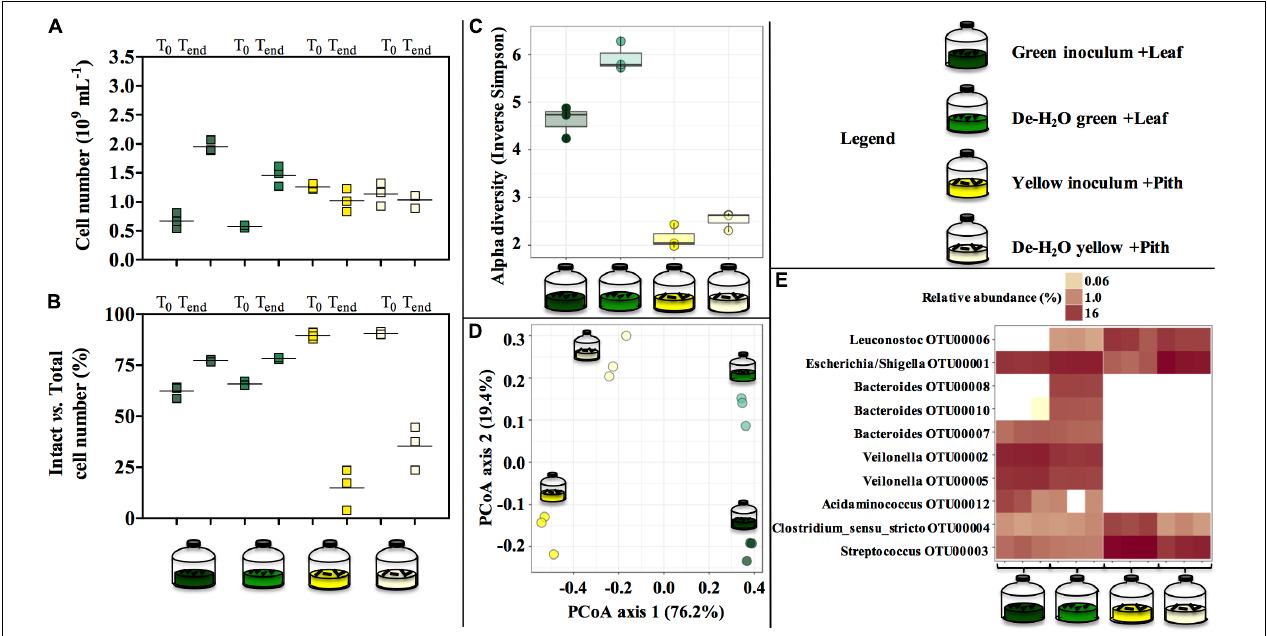
FIGURE 5 | Cell number (A) , percentage of intact cells over total cell number (B) and microbial community composition (C–E) at the end of laboratory-scale incubations ( n = 3, A – E ) using microbiomes derived from giant panda fecal samples ( Figure 2 ). Total cell number and number intact cells (A,B) was determined according to Live-Dead staining and flow cytometry; squares indicate single replicates, and black lines indicate the mean value. Alpha diversity (Hill order 2, Inverse Simpson index) of the microbial community in giant panda fecal matter (C) ; circles indicate each single replicate, whiskers indicate min to max values, and black lines the mean average. Beta diversity analysis by means of principal coordinate analysis (PCoA) of the microbial community in giant panda fecal matter (D) . In (E) the top 10 most abundant OTUs across all samples were selected (all data in Supplementary Table S3 ). A 3% dissimilarity threshold was used to define OTUs. Keys reported in the